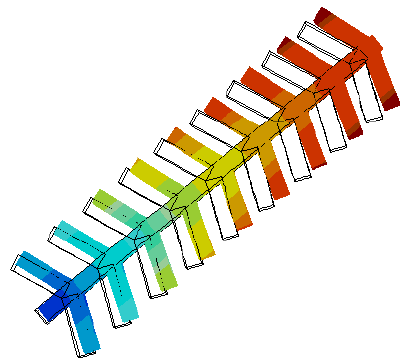
Figure 9. Displacement resulting from applying face forces on the comb